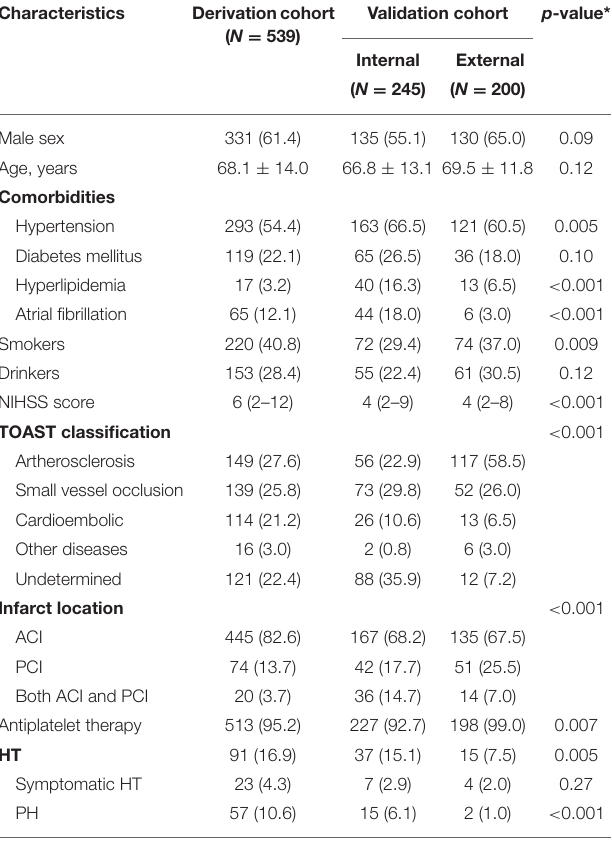
TABLE 2 | Univariate analysis to identify potential predictors of spontaneous hemorrhagic transformation in the derivation cohort. Variables